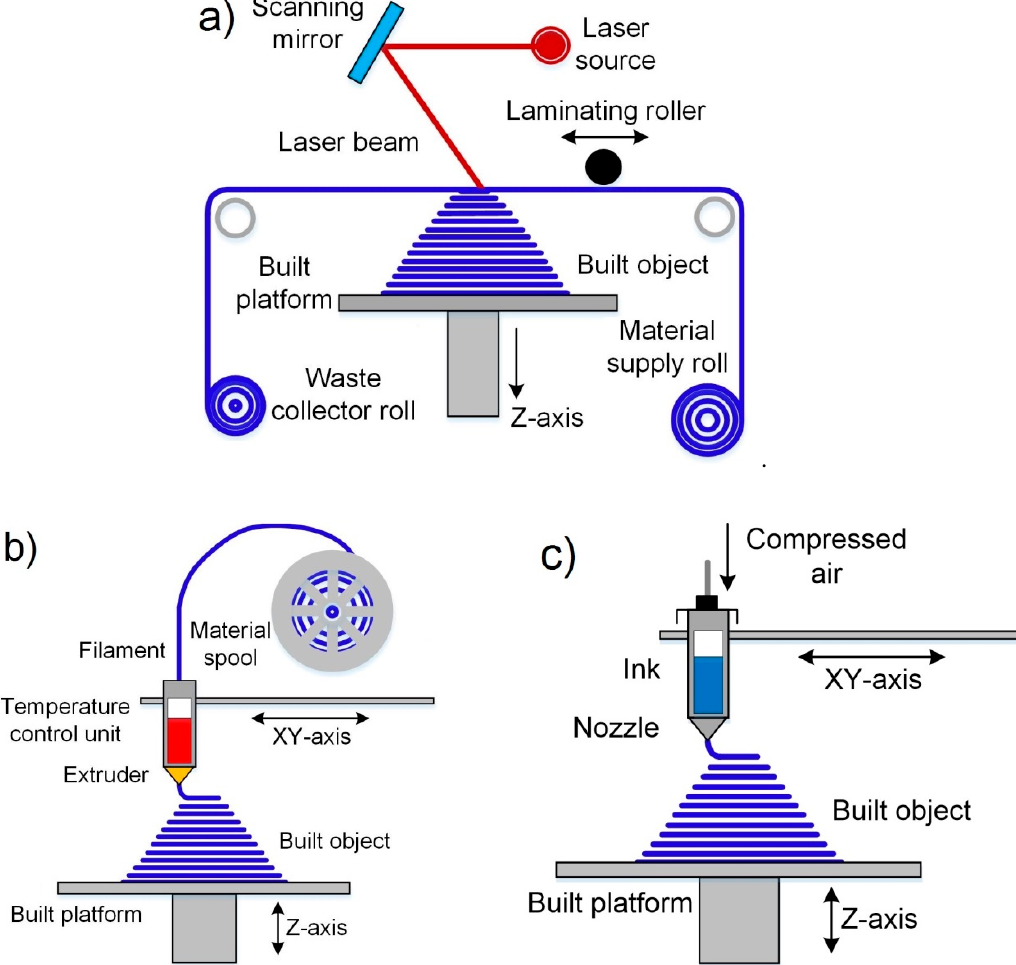
Figure 5. Schematic diagrams of bulk solid-based AM technology main methods: ( a ) LOM; ( b ) FDM; ( c ) direct ink writing (DIW). Figure 5 a , b adapted from [44], with permission from Wiley-VCH Verlag GmbH & Co. KGaA, Weinheim, 2018.